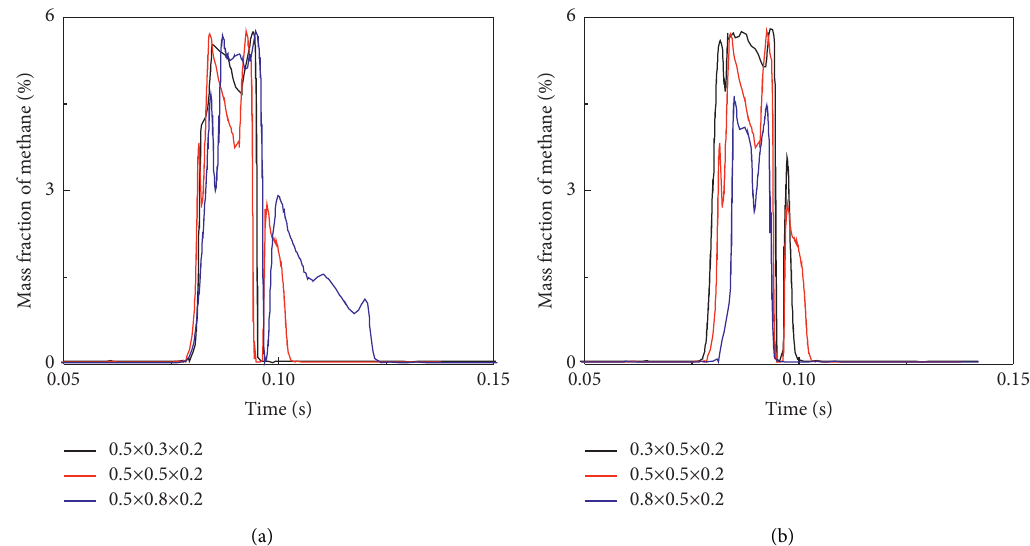
Figure 9: Methane mass concentration at the outlet of chambers with different geometric parameters. (a) Variable-width chambers (0.2m high and 0.5m long); (b) variable-length chambers (0.2m high and 0.5m